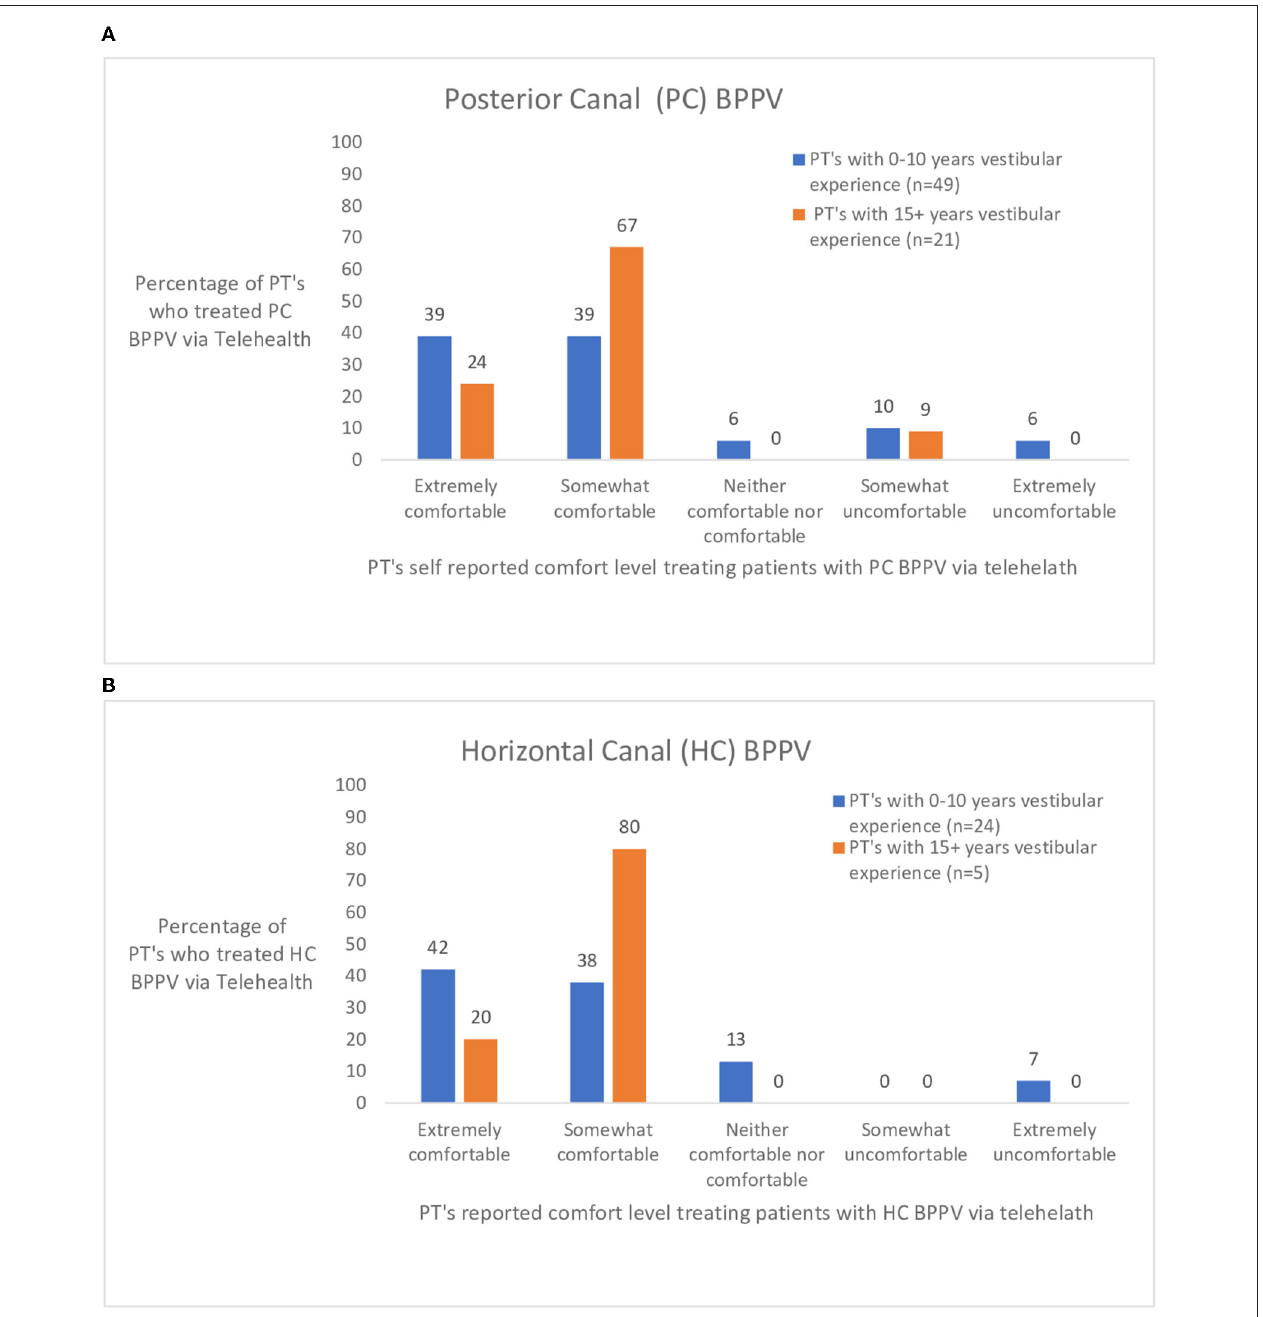
FIGURE 2 | (A,B) Rating by physical therapists (PT’s) with 0–10 and 15 + years of vestibular experience who treated persons with posterior (PC) and horizontal canal (HC) benign paroxysmal positional vertigo (BPPV) via